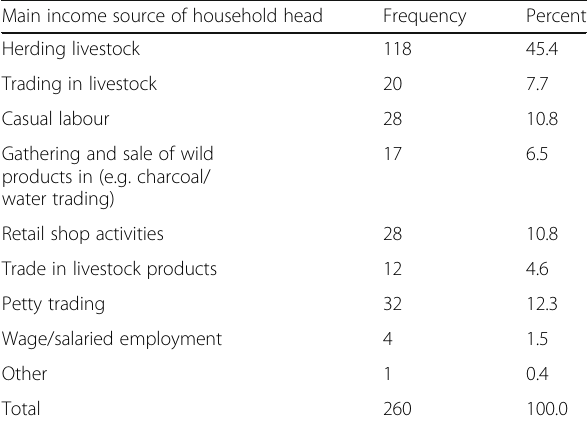
Table 2 Main income source of household